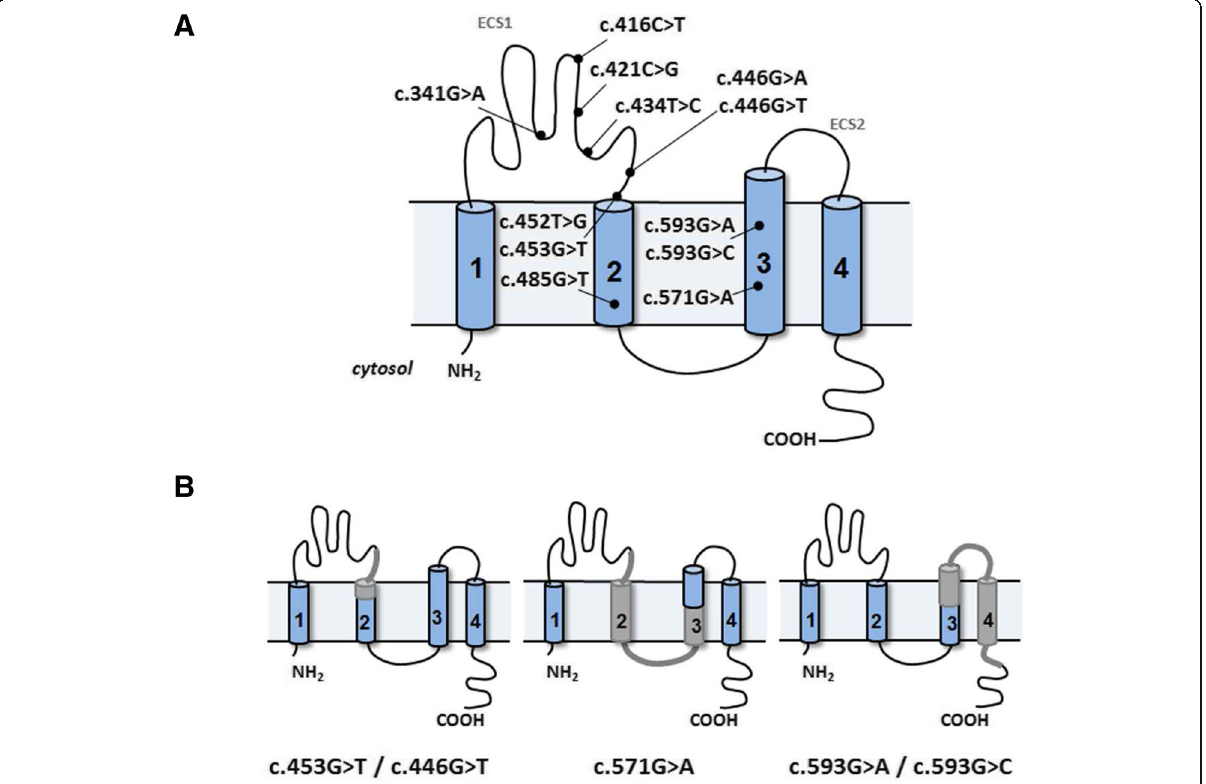
Fig. 1 Diagrammatic representations of claudin-16. a The protein contains four TMDs (1 – 4) and two ECSs (1 – 2). ECS1 contains the ion selectivity filter while ECS2 is involved in claudin – claudin interactions. The location of the mutations included in this study is indicated. b Hypothetical protein structures of mutant claudin-16 proteins translated from the aberrant transcripts detected in Fig. 3a. Truncated exon 3 induced by mutations c.446G > T and c.453G > T would result in loss of the terminal part of ECS1 and part of TMD2. Skipping of exon 3 produced by mutation c.571G > A would cause loss of the terminal part of ECS1, TMD2, the cytoplasmic region and part of TMD3. Skipping of exon 4 induced mutations c.593G > A and c593G > C would result in loss of part of TMD3, ECS2, TMD4, and part of the cytoplasmic C